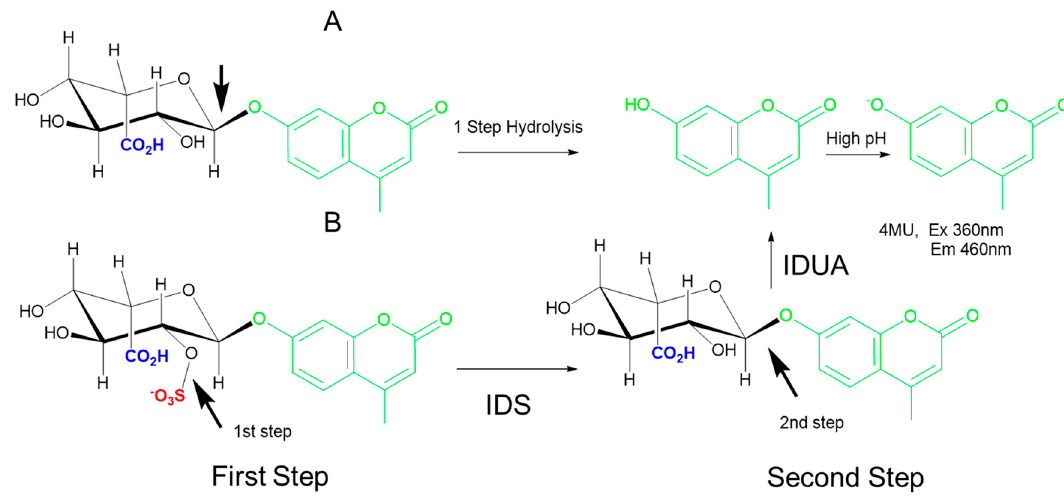
Figure 4. Examples of one-step and two-step hydrolysis reactions. ( A ) The one-step hydrolysis of the 4-methylumbelliferyl derivative (4-MU)-IdoA substrate cleaves the glycosidic bond indicated by the arrow to liberate 4-MU, which is measured under high pH conditions. ( B ) The two-step hydrolysis of 4-MU-IdoAS requires cleavage of the red sulfate first (arrow in left bottom) to yield 4-MU-IdoA. In the second step of the reaction (bottom right), IDUA cleaves the glycosidic bond indicated by the arrow to liberate 4-MU, which is measured under high pH conditions. IDS: α -iduronide sulfatase; IDUA: α -iduronidase.